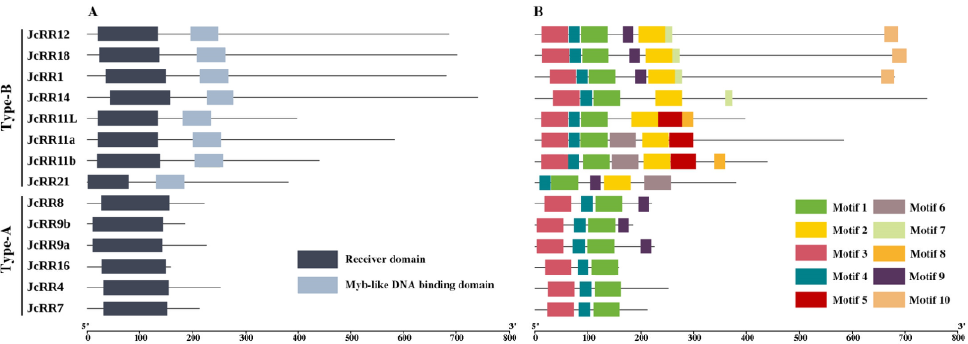
Figure 4. Analysis of the conserved domain and motif elements of the RR gene family members in J. curcas . ( A ) Domain structure of RRs; ( B ) Motif composition of JcRRs. Each motif is represented by a specific color.